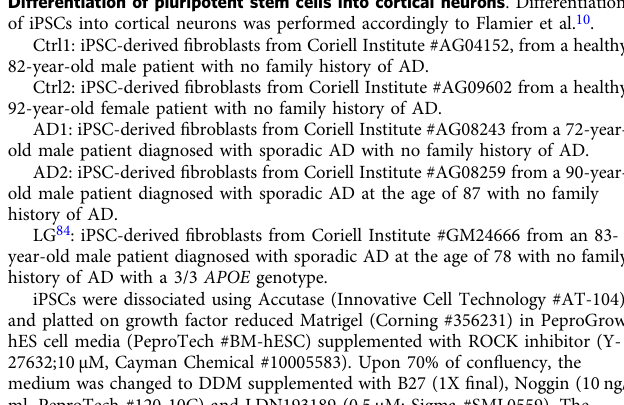
Fig. 5 1H6 peaks are enriched at key regulatory elements of neuronal genes. a Venn diagram and Gene Ontology analysis of genes associated with peaks common to both Ctrl2 and AD1 neurons or speci fi c to AD neurons (AD1). The most signi fi cant pathways are indicated on the diagram along with the respective P value calculated by the GO algorithm. b Sashimi plot of three different loci containing a 1H6 peak and associated with a differential splicing event. Exons are represented as blue boxes. The red lines represent a peak found in AD neurons; the green lines represent a peak found in control (Ctrl) neurons green. Loss of the intragenic peak in AD neurons between the SMN1 and NAIP genes is associated with the formation of cryptic fusion transcripts. The common peak found at the APP locus (but increased in AD) is associated with loss of some minor isoforms in AD neurons. The unique peak gained in AD neurons at the DNAH6 locus is associated with loss of minor isoforms and a large splicing gap in AD neurons. c Table showing the number of genes containing a 1H6 peak, as well as the number of genes that entailed a differential splicing event associated with a 1H6 peak when comparing Ctrl1 and Ctrl2 neurons with AD1 neurons. The splicing events were subdivided into loss of a minor isoform or formation of a gap junction. d Western blot analyses of Ctrl2 and AD2 neurons. GAPDH and ponceau were used as normalizers. Black arrows indicate differentially expressed protein variants. e Volcano plot showing differential gene expression between control (Ctrl1 and Ctrl2 combined) and AD1 neurons using RNA-seq. Superimposed in red are genes containing a G4 peak and associated with an abnormal splicing event. Note that genes in the third volcano plot (i.e., gained in AD) are signi fi cantly downregulated, and genes in the fi rst volcano plot (i.e., lost in AD) are signi fi cantly upregulated in AD1. For each gene distribution (red dotted ovals), a P value was calculated using binomial distribution, knowing that 51% of the genes